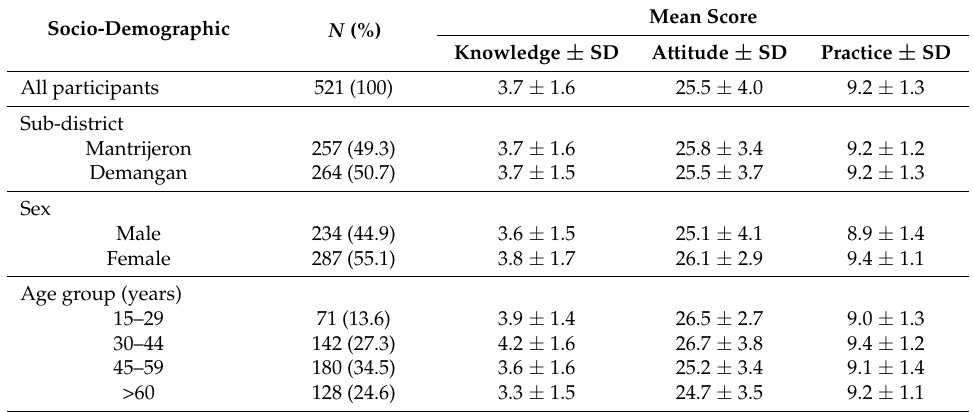
Table 1. Characteristic of participants and KAP (knowledge attitude and practice) mean